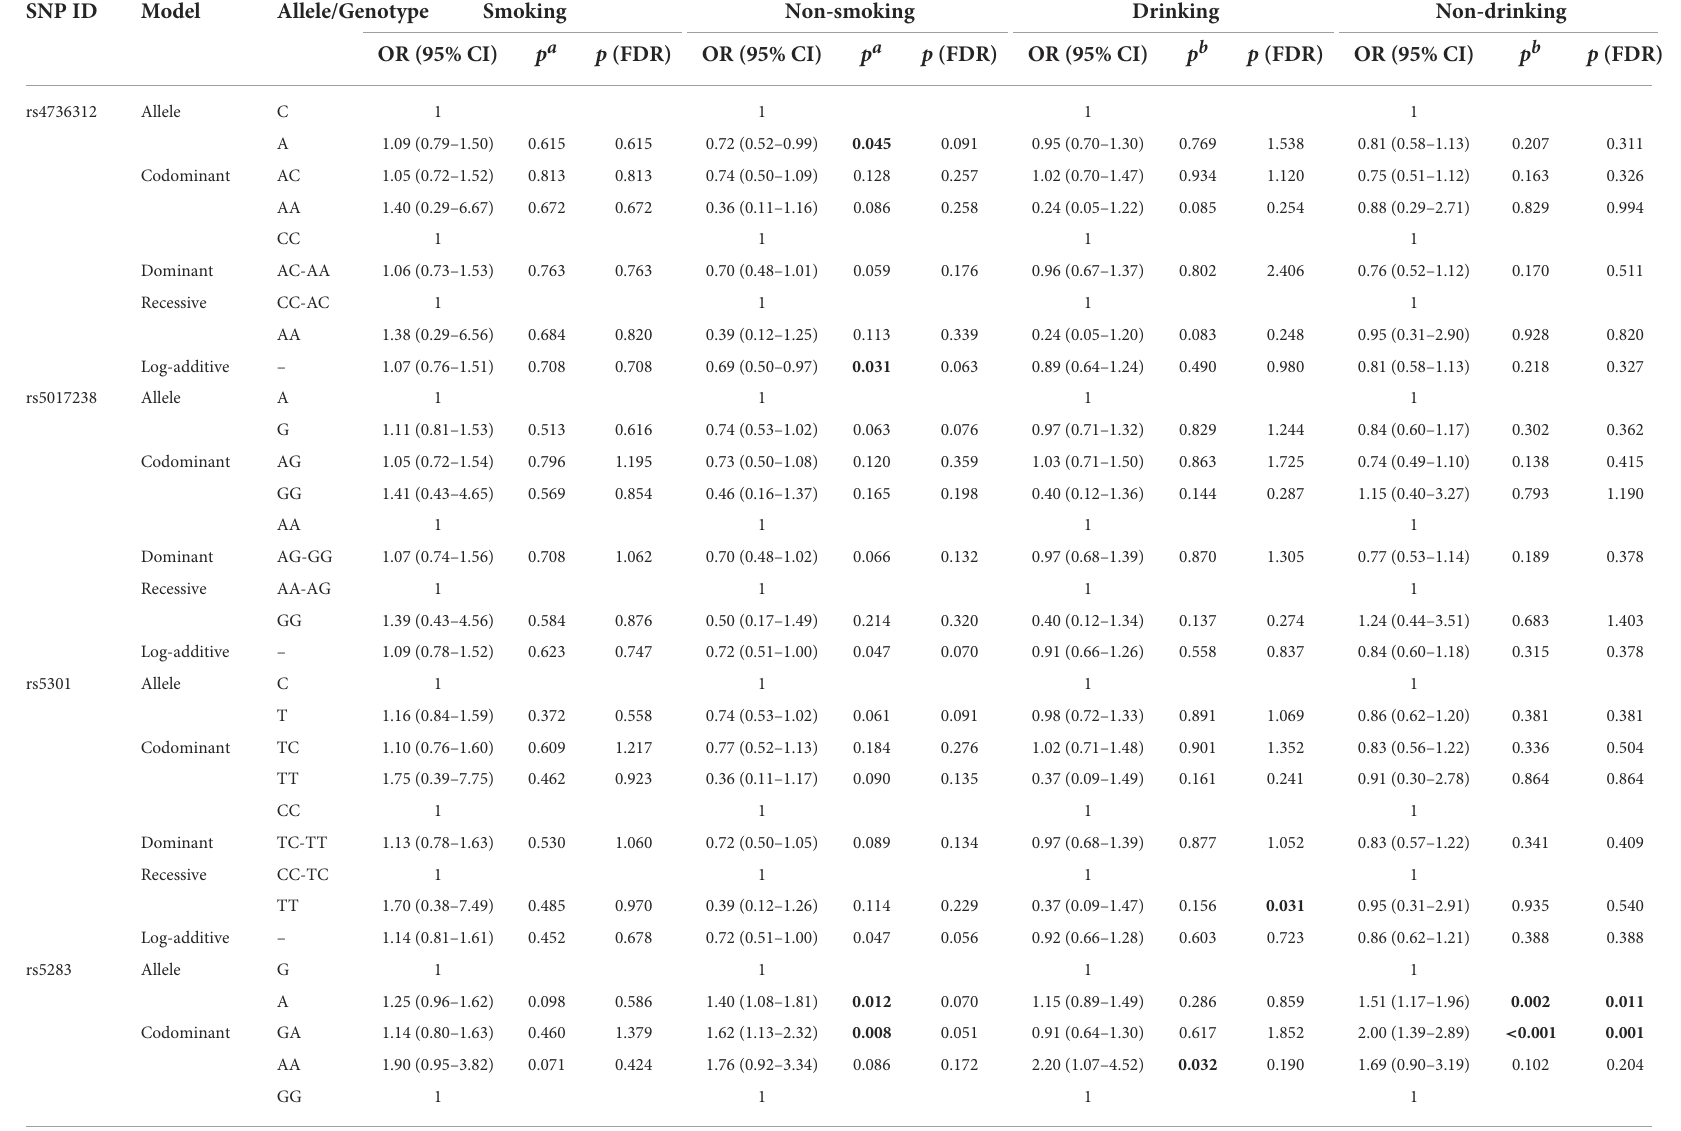
TABLE 5 Correlation of CYP11B1 polymorphisms and ischemic stroke susceptibility stratified by smoking and